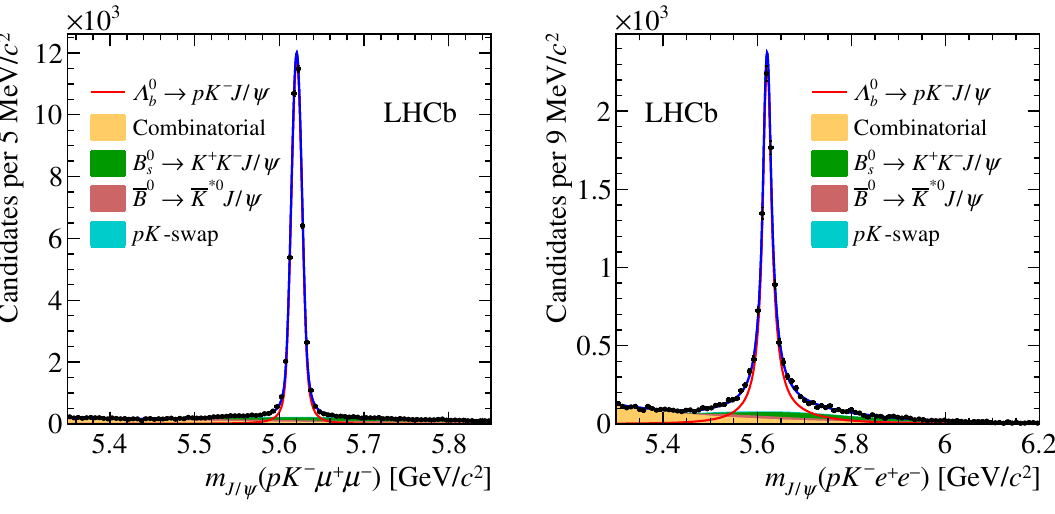
m ] 2 c ) [GeV/ − e + e − pK ( ψ / J Figure 2. Invariant-mass distribution, with the J= mass constraint applied, of (cid:3) 0 ! pK (cid:0) J= ( ! (cid:22) + (cid:22) (cid:0) ) (left) and (cid:3) 0 ! pK (cid:0) J= ( ! e + e (cid:0) ) (right) candidates, summed over trigger b b and data-taking categories. The black points represent the data, while the solid blue curve shows the sum of the (cid:12)t to the di(cid:11)erent categories. The signal component is represented by the red curve and the shaded shapes are the background components, as detailed in the